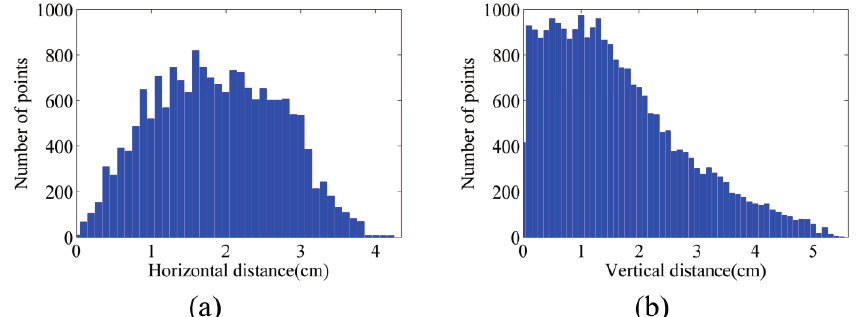
Figure 23. Histograms of distances between the point clouds from dataset C and laser scanner ( a ) Horizontal distances; ( b ) Vertical distances.